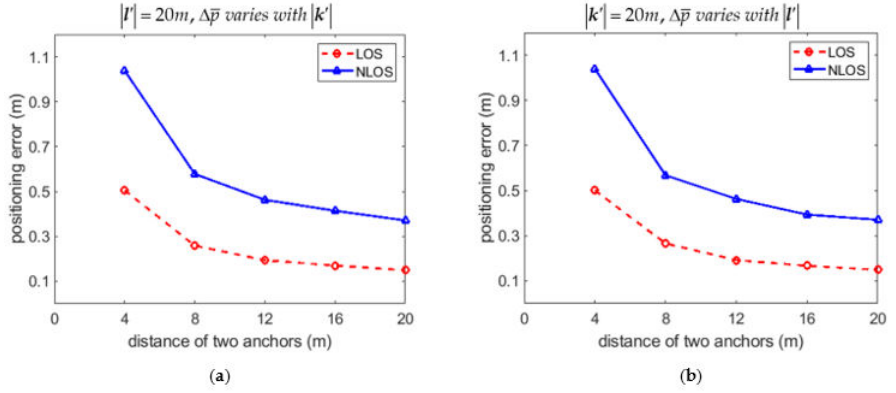
(cid:12) (cid:12) (cid:12) (cid:12) (cid:12) k (cid:48) (cid:12) and (cid:12) l (cid:48) (cid:12) . ( a ) Variation of ∆ p (cid:12) (cid:12) (cid:12) (cid:12) (cid:12) l (cid:48) (cid:12) provided that (cid:12) k (cid:48) (cid:12) = 20 m